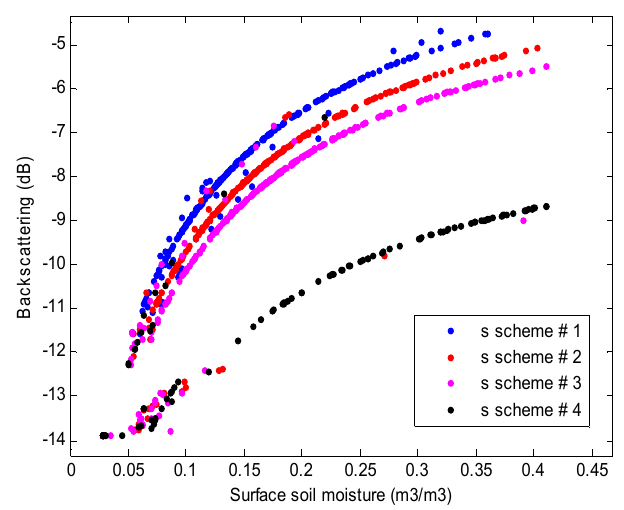
Figure 1. Roughness experiments: a change in relationships between ASAR backscattering and soil moisture retrieved with various RMS height conditions.